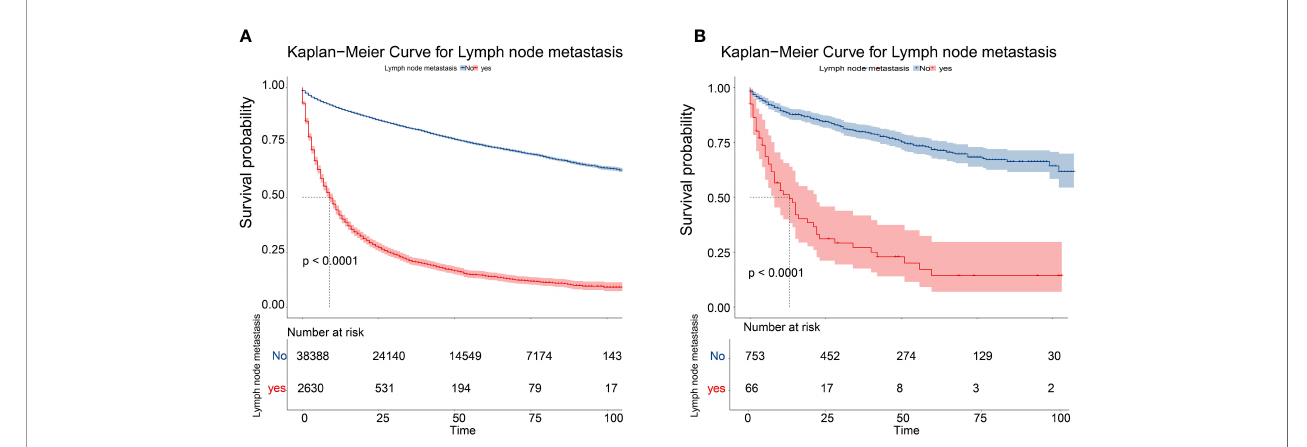
FIGURE 6 | Kaplan – Meier overall survival curves of patients with LMs or not in the training cohort (A) and the validation cohort (B)